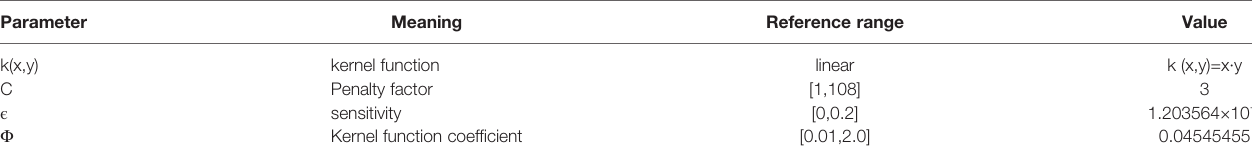
TABLE 1 | PSO-SVR model